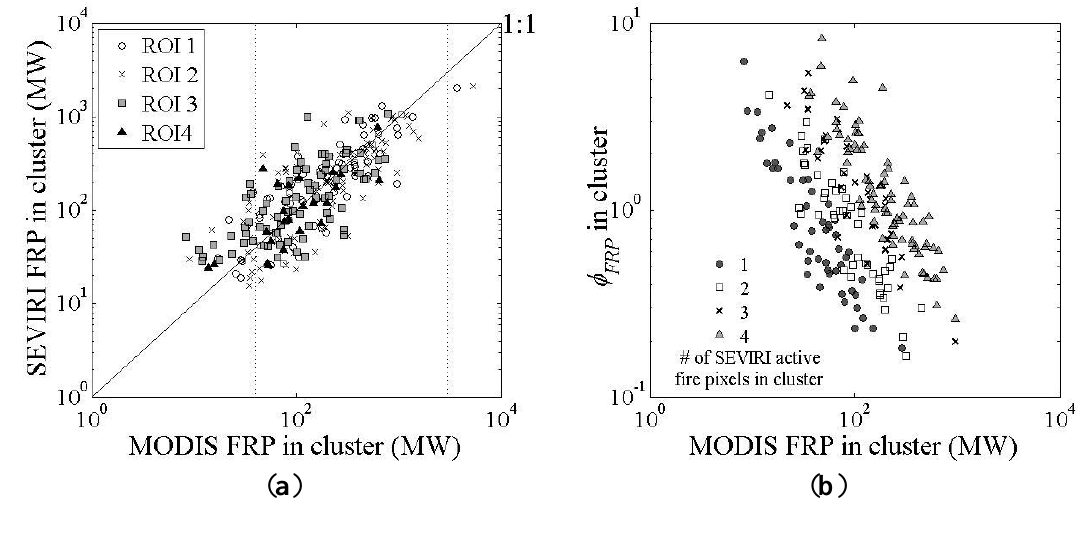
Figure 11. Comparison between the fire radiative power (FRP) emitted from well-observed fire pixel clusters simultaneously detected by SEVIRI and MODIS. All clusters are completely surrounded by SEVIRI “non-potential fire pixels”. In ( a ) is the direct relationship, and in ( b ) is the ratio of the FRP measured by SEVIRI to that measured by MODIS, ϕ , on a cluster basis and sorted by the number of SEVIRI active fire FRP pixels detected in each cluster. Note: SEVIRI clusters with >5 active fire pixels are not included in